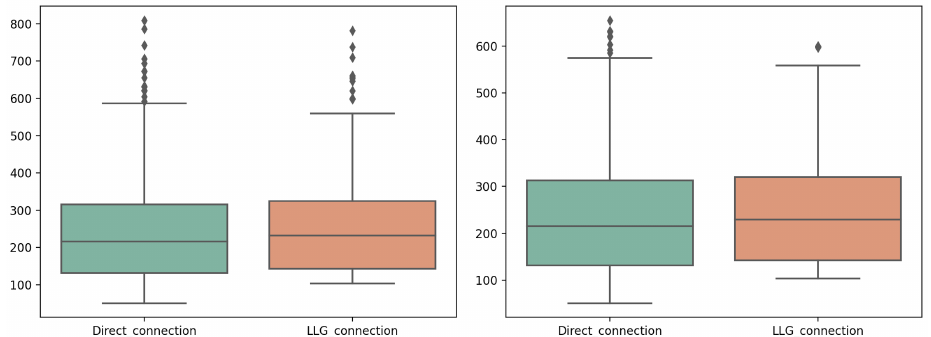
Figure 13. Dataset comparison (N = 500). Response time including outliers ( left ) and statistically removed outliers ( right ).